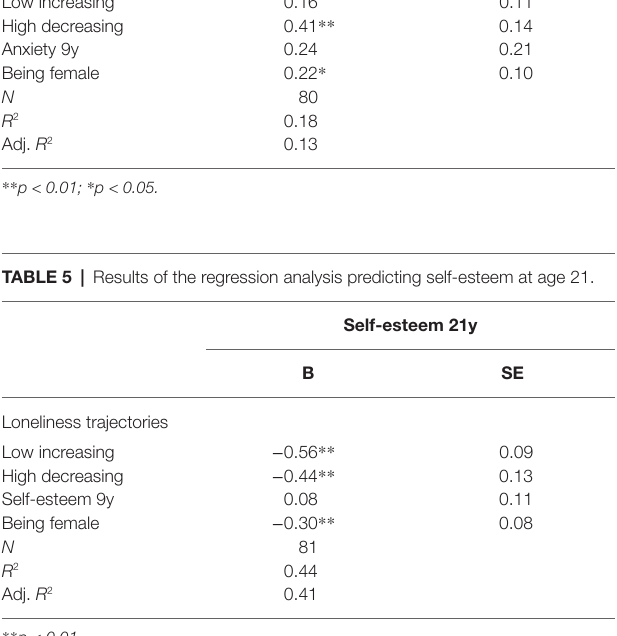
TABLE 2 | ASD and DIF measures for the three clusters (Leffondré et al., 2004).